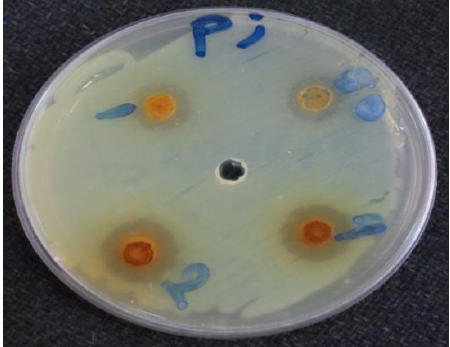
Figure, 2: Inhibition zones of Proteus spp. growth on Figure, 3: Inhibition zones of Proteus spp. growth on Mueller-Hinton agar produced by ethanolic extract Mueller-Hinton agar produced by ethanolic extract of Cinnamomumzeylanicum , the peripheral four of Ginger officinale , the peripheral four wells wells contained extract concentrations ( 50, 100, contained extract concentrations ( 50, 100, 200, 400 200, 400 mg/ml) whereas the central well contained mg/ml) whereas the central well contained 0.1 ml of 0.1 ml of 96% ethanol . 96% ethanol .